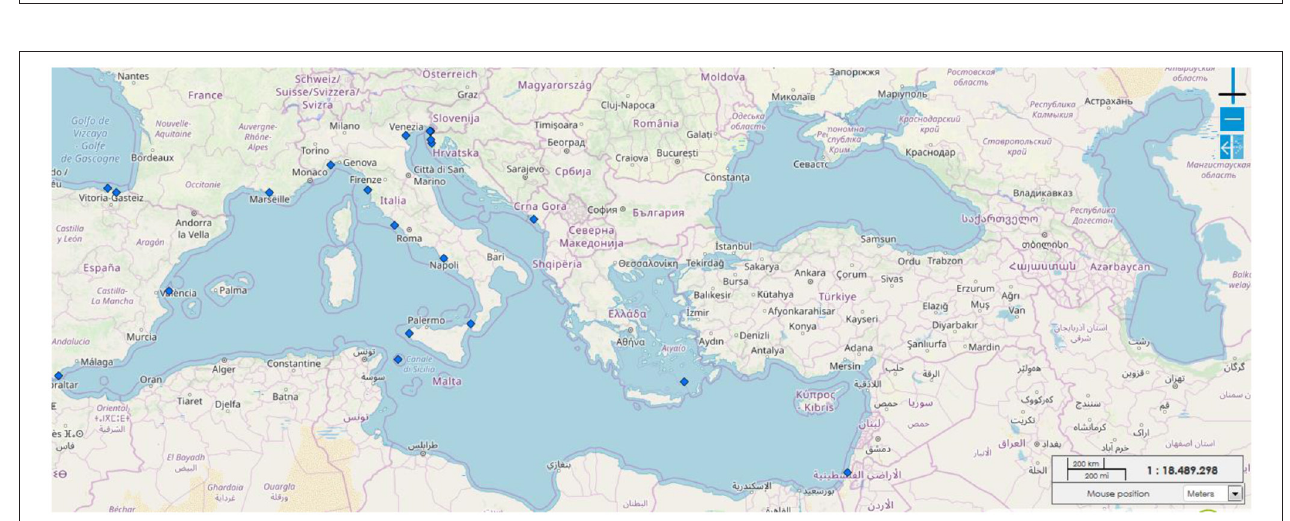
FIGURE 1 | RES consumption per category (European Environment Agency, 2018).